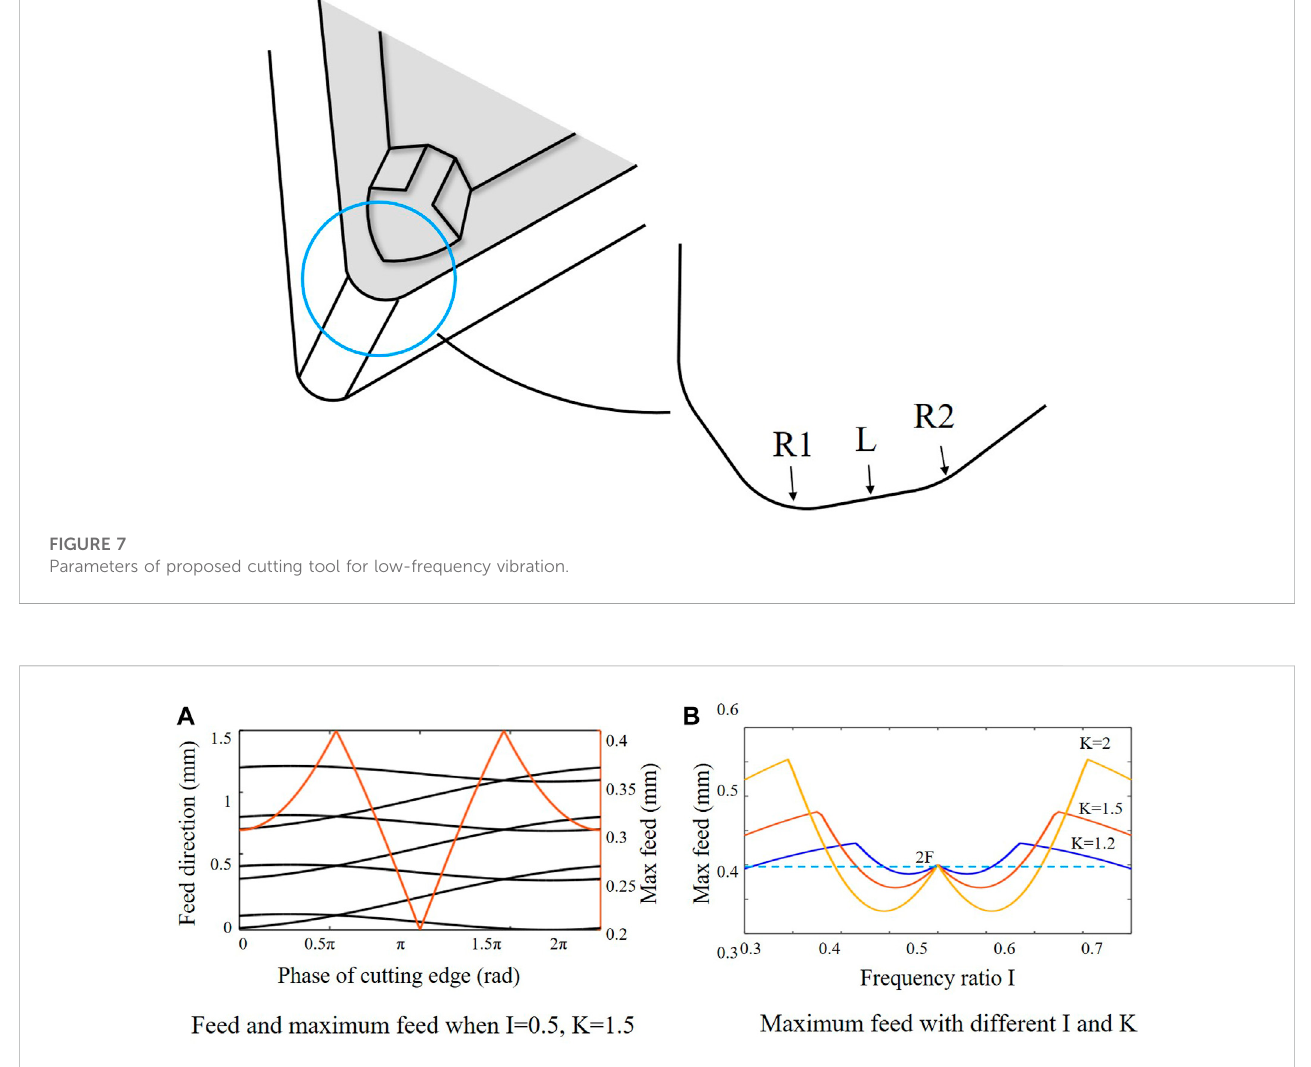
FIGURE 8 Maximum feed amount in low-frequency